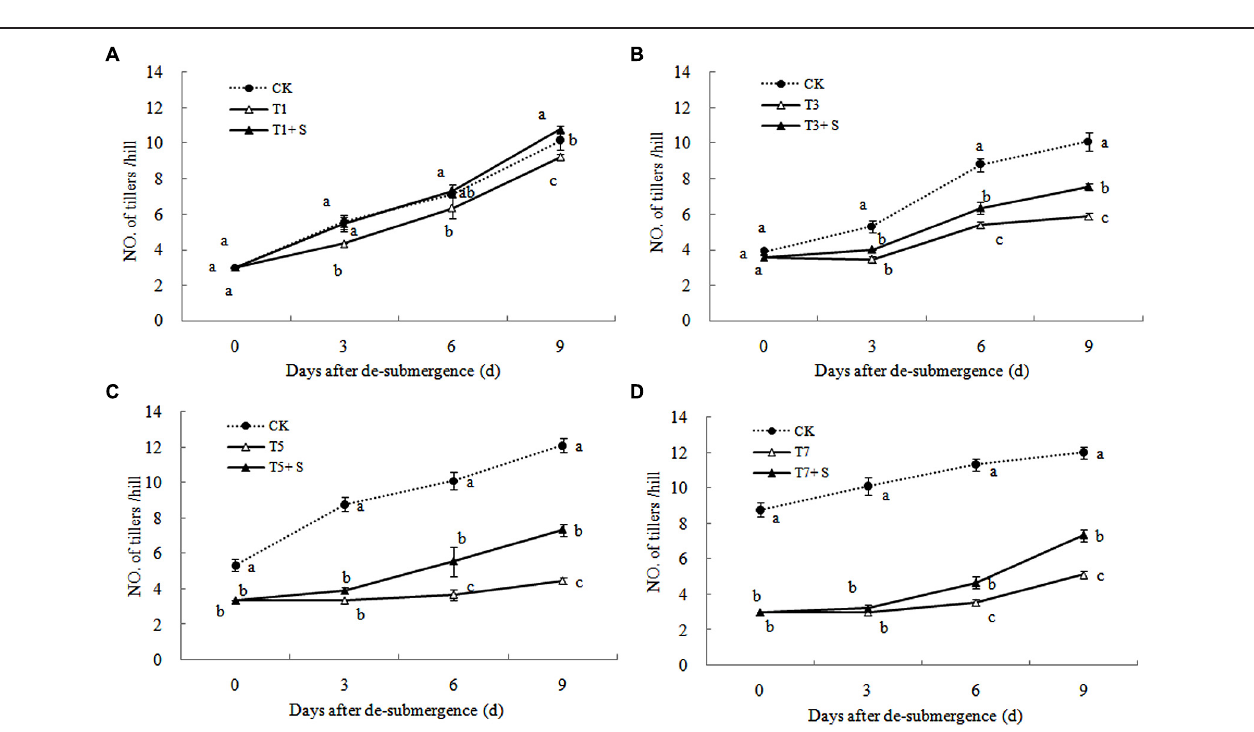
Frontiers in Plant Science |